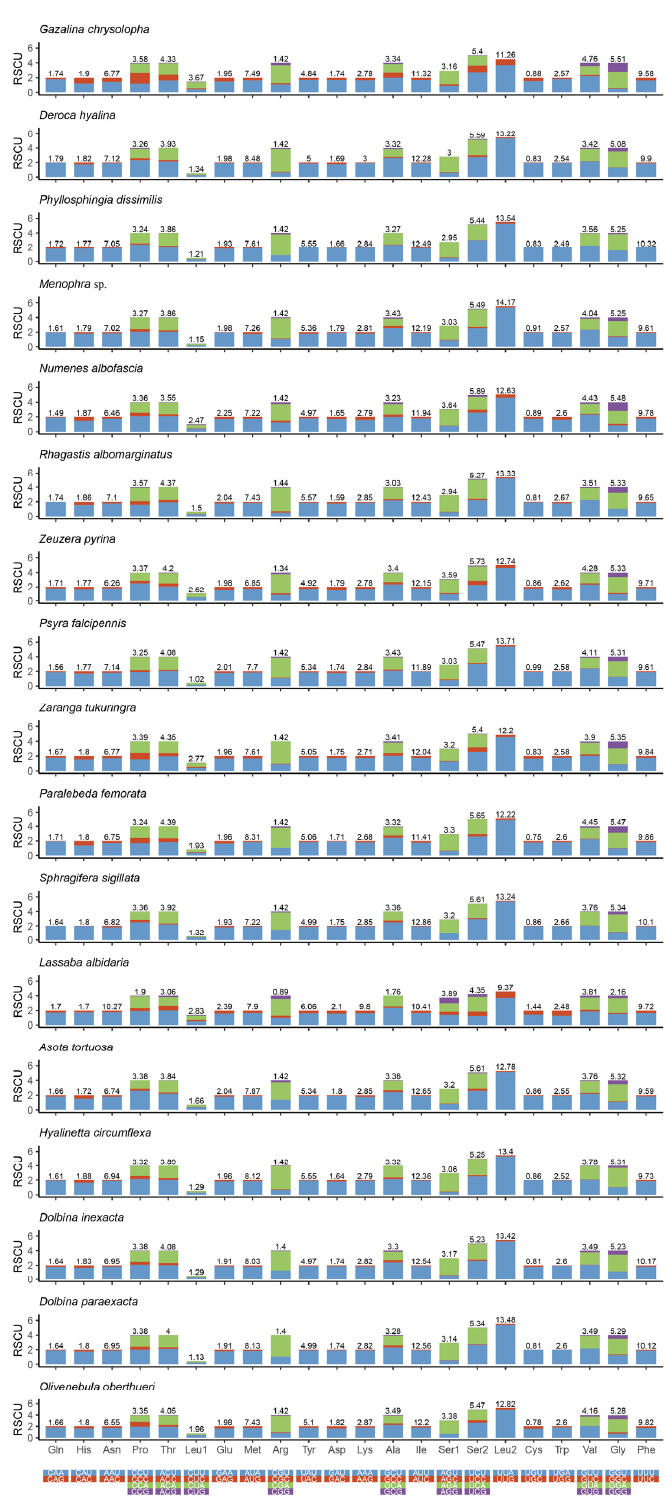
Figure 2. Relative synonymous codon usage (RSCU) and codon distribution in PCGs of 17 moths mitogenomes. Codon families are indicated below the x ‐ axis.